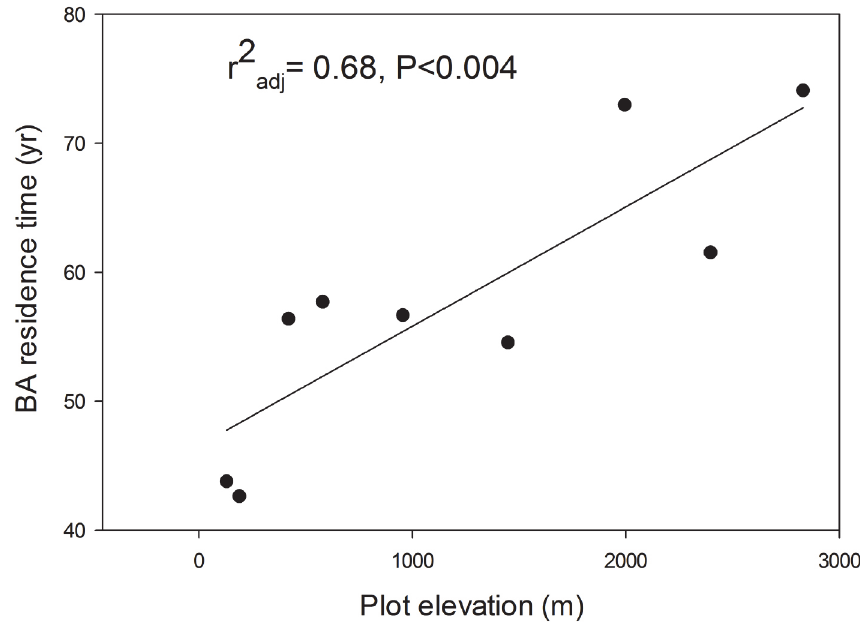
Fig 5. Basal area residence times. Rates of basal area residence time along an elevational transect in Costa Rican rain forest. Basal area residence time was calculated as the mean plot basal area over the interval divided by the mean rate of plot basal area addition (stocks divided by flux).